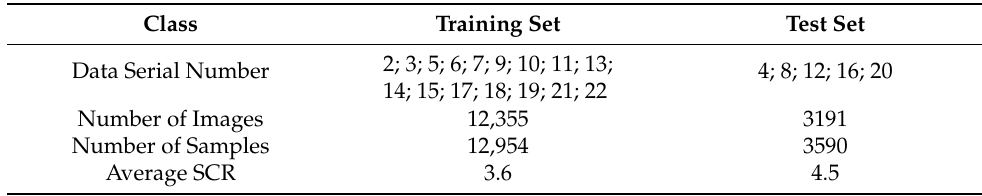
Table 1. Division of the